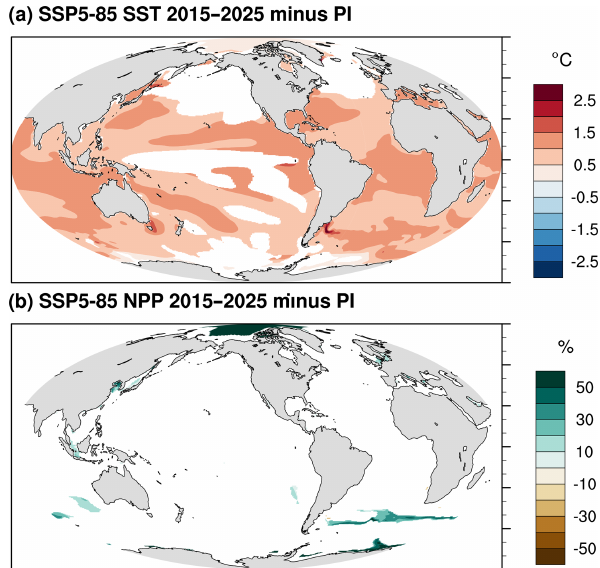
Figure A2. Simulated sea surface temperature (SST) anomaly (a) and % change in net primary productivity (NPP) (b) in SSP5-8.5 2015– 2025 relative to pre-industrial long-term means. Regions shaded in color are significant with 95% confidence, assuming normally distributed data.